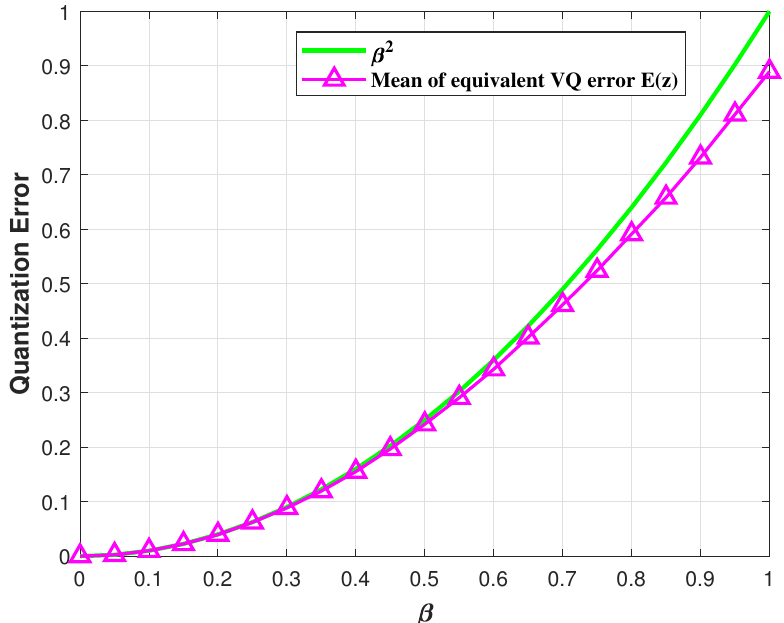
Figure 2. Comparison of β 2 and the expectation of the equivalent VQ